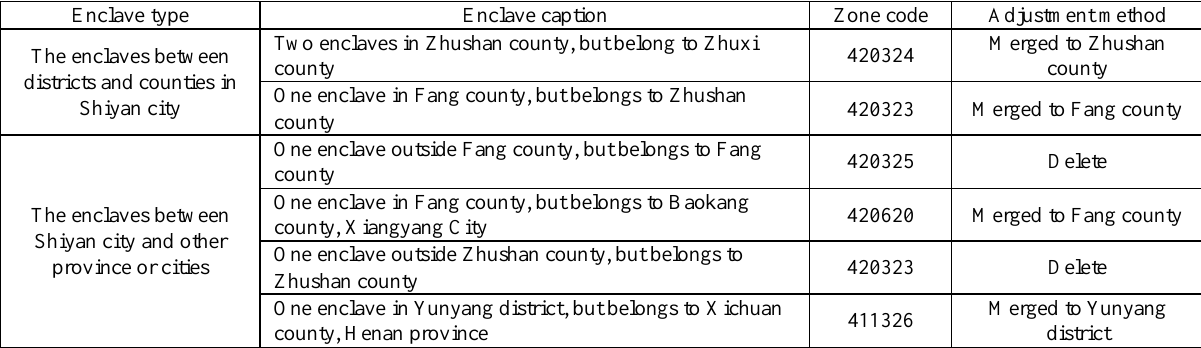
Table 2. Adjustment method of enclaves in the study